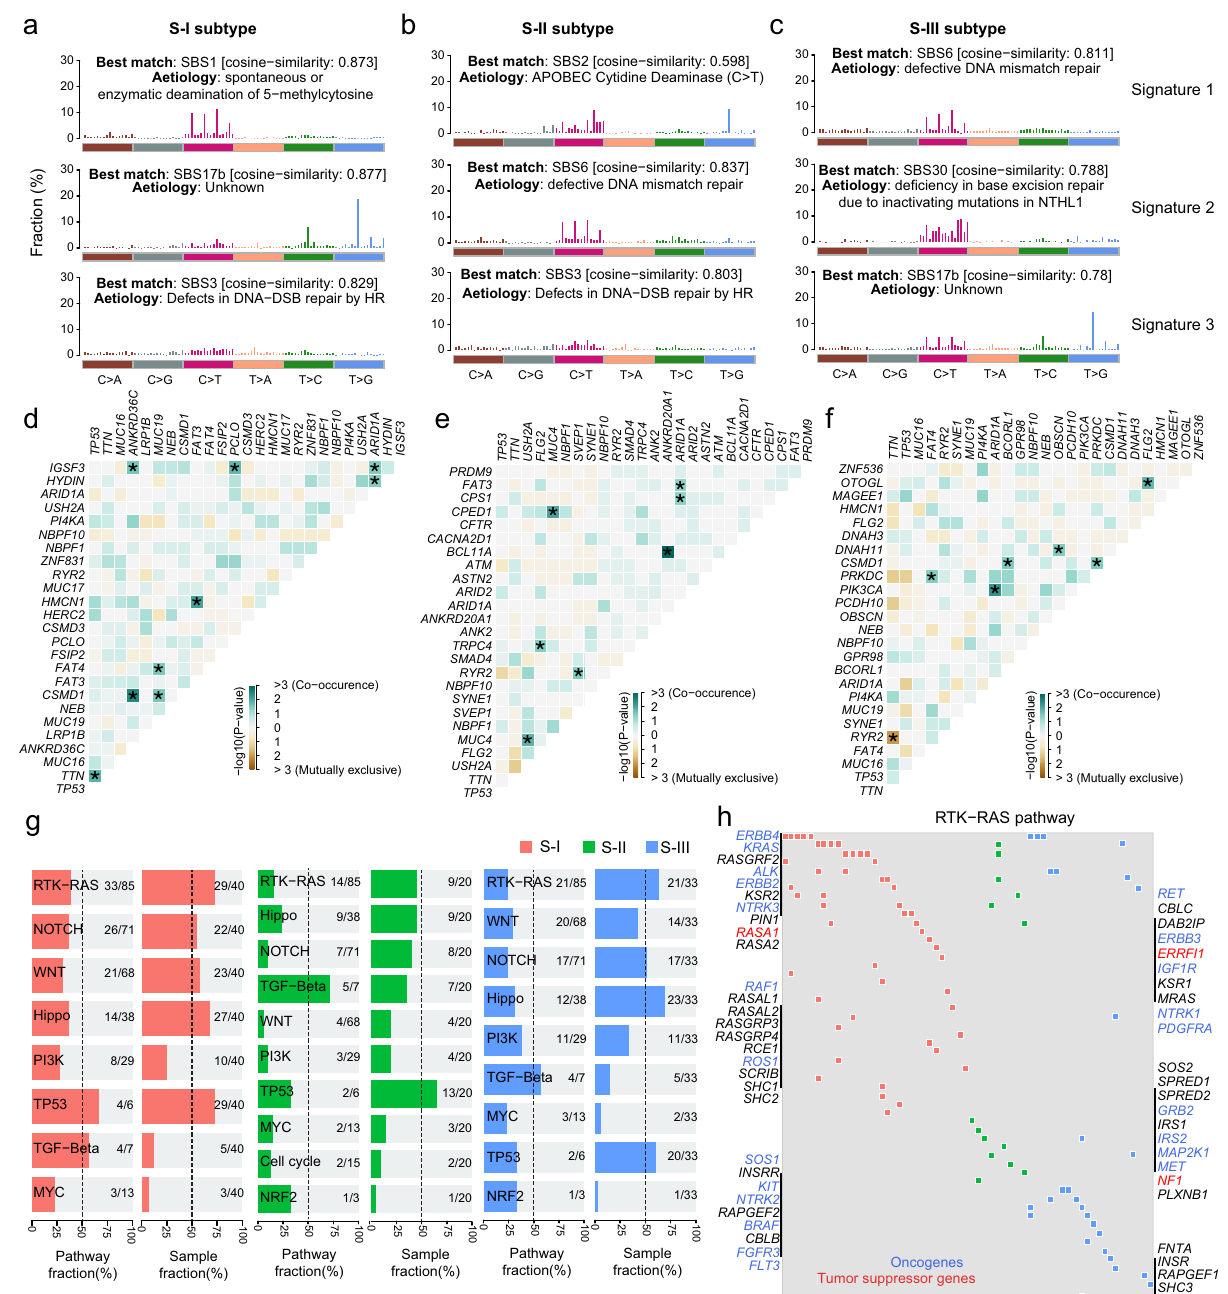
Fig.5|Comparisonsofgenomicfeaturesamongthethreeproteomicsubtypes. Mutation signatures and the best match SBS signatures in the S-I ( a ), S-II ( b ), and S-III ( c ) subtypes. Somaticinteractionsof the top mutated genes in the S-I ( d ),S-II ( e ), and S-III ( f ) subtypes. Asterisks indicate statistical signi fi cance (Fisher ’ s